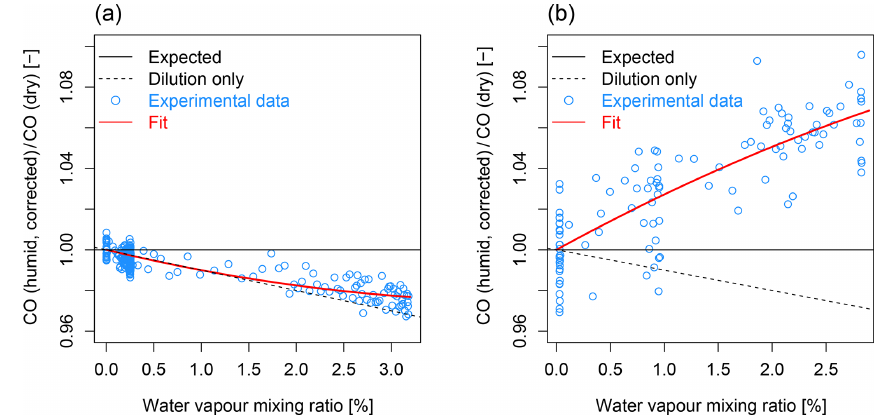
Figure 9. CO (humid, corrected)/CO (dry) vs. the reported water vapour for the experiment before (a) (23 March 2016) and after (b) (14 July 2016) the comparison at